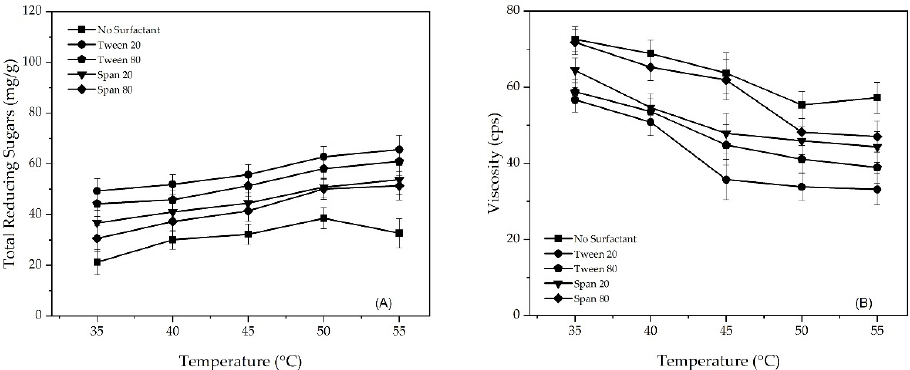
Figure 4. The profile of total reducing sugars increment ( A ) and viscosity decline ( B ) in the chitosan enzymatic hydrolysis at various temperatures. enzymatic hydrolysis at various